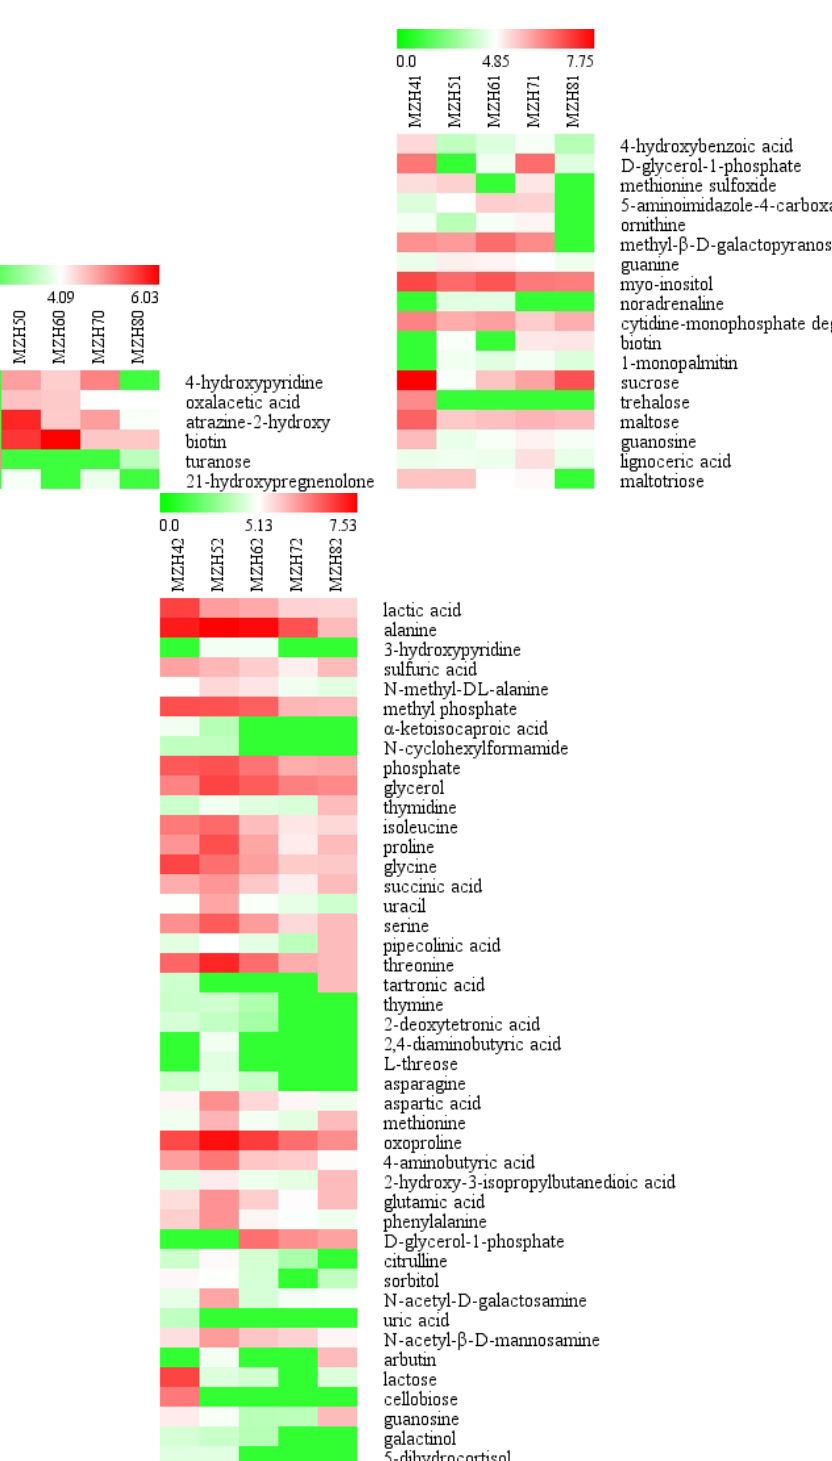
Figure 9. Heatmap of the abundance of identified metabolites in the mycelia of Epichloë sinensis under each selenium concentration throughout weeks 4 to 8. Red and green blocks indicate higher or lower metabolite levels (see scale bar). MZH40, MZH50, MZH60, MZH70, and MZH80 represent mycelia grown in the absence of Se for 4, 5, 6, 7, and 8 weeks, respectively. MZH41, MZH51, MZH61, MZH71, and MZH81 represent mycelia grown in the presence of 0.1 mmol/L Se during weeks 4 to 8. MZH42, MZH52, MZH62, MZH72, and MZH82 represent mycelia grown in the presence of 0.2 mmol/L Se during weeks 4 to